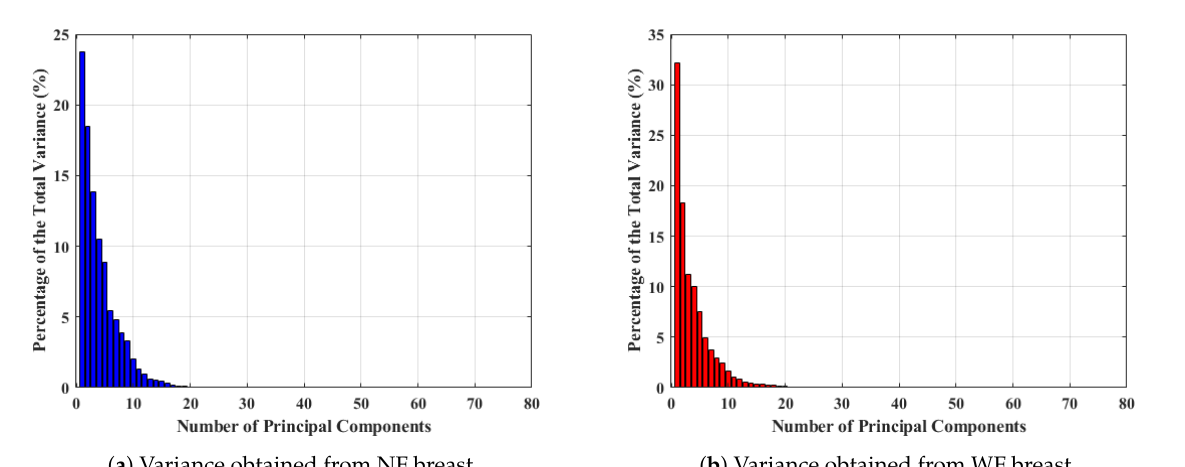
Figure 4. Percentage of variance obtained for 80 PCs measured from Real S 21